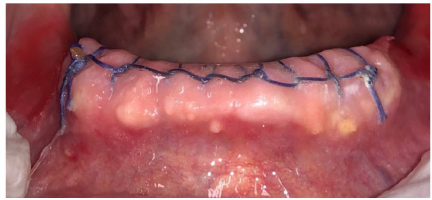
Figure 5. 3 days after surgery, Group A.